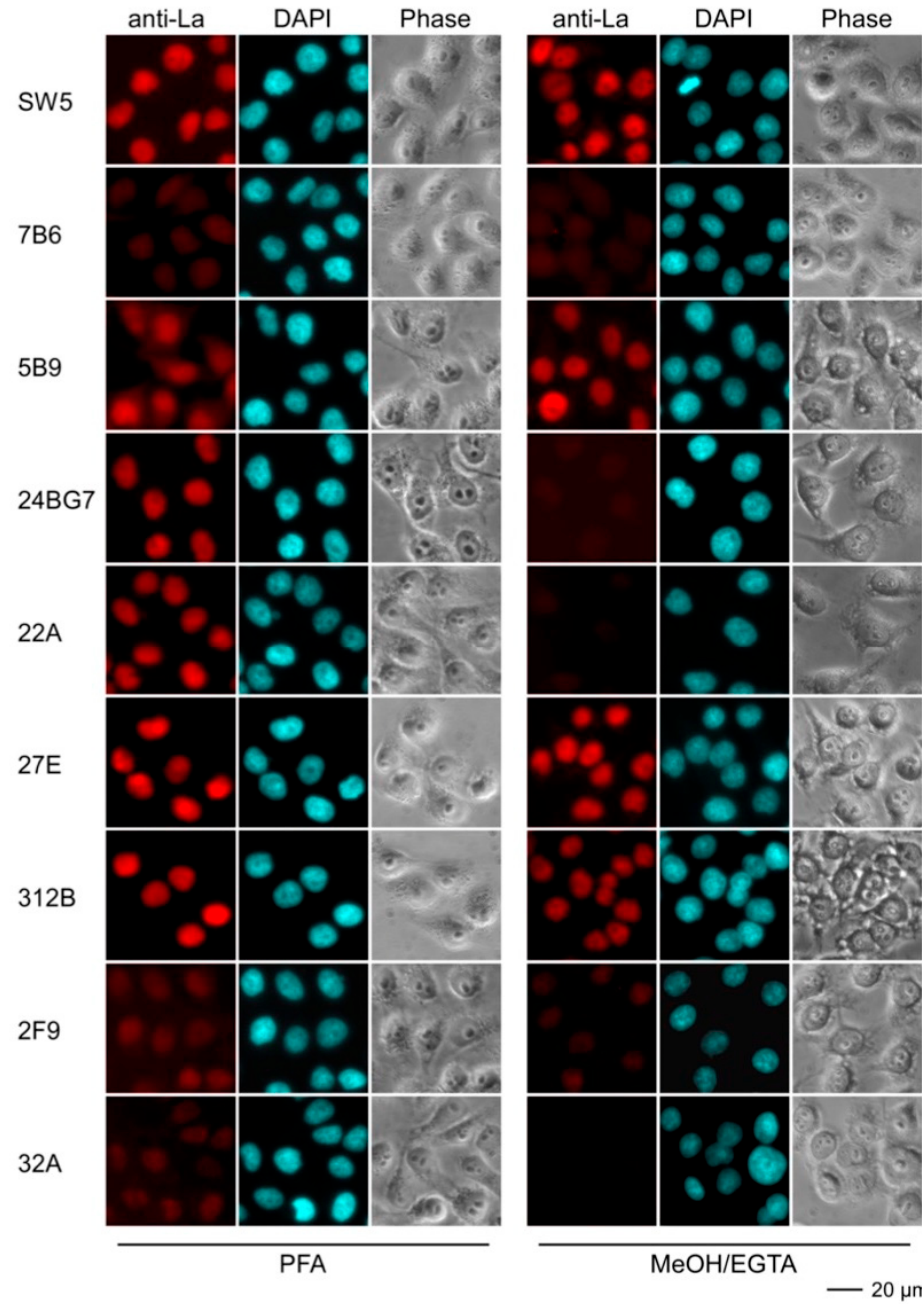
Figure 8. Epifluorescence microscopy of human HeLa cells stained with anti-La mabs. Prior to the staining, cells were fixed with either paraformaldehyde (PFA) or methanol (MeOH)/EGTA. For detection of the primary anti-La mabs, we used an anti-mouse-IgG ab conjugated with Alexa Fluor ® 568 as secondary ab. DNA was stained with DAPI. Phase, phase contrast image.